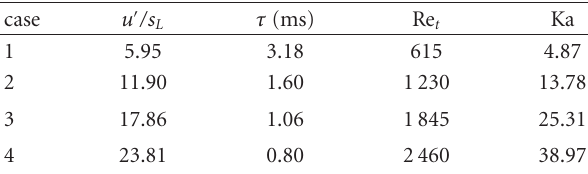
Table 1: Initial turbulence